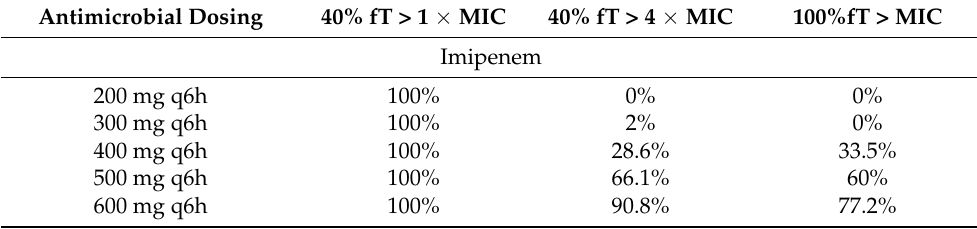
Table 3. Probability of Target Attainment for Imipenem with Monte Carlo Simulation Approach in Modeled CRRT